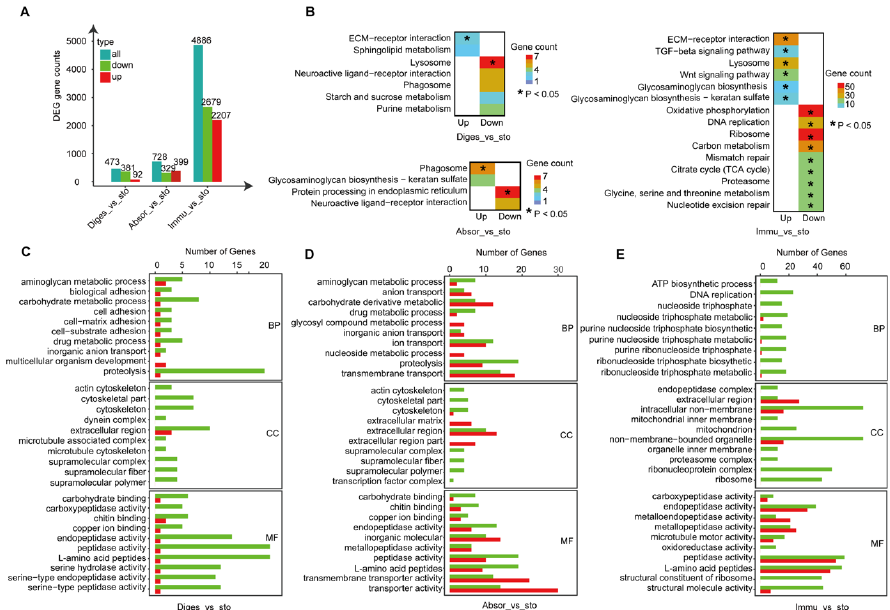
Figure 3. Comparison of the digestive segment, middle, and distal intestine with the stomach. ( A ) DEGs between stomach and digestive segment, absorption segment, and immune segment. ( B ) KEGG pathway analysis for up-regulated genes and down-regulated genes in digestive segment vs. sto, absorption segment vs. sto, and immune segment vs. sto. ( C – E ) GO enrichment analysis for up-regulated genes and down-regulated genes in digestive segment vs. sto, absorption segment vs. sto, and immune segment vs. sto. The colors correspond to the A panel. (Sto: stomach, Diges: digestive segment, Absor: absorption segment, Immu: immune segment).